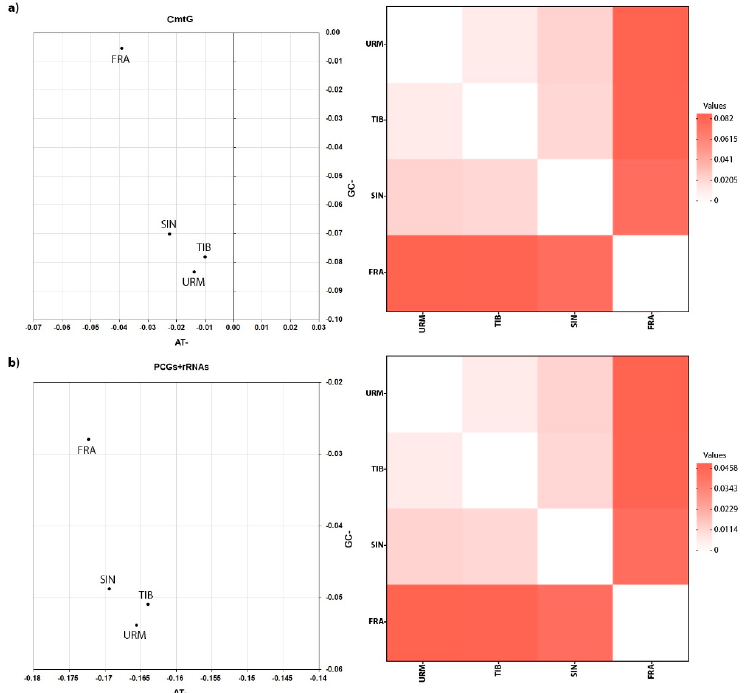
Figure 9. Distribution of species on scatter plots (left) and heat-map pairwise comparison (right) based on AT- and GC-skew values of CmtG ( a ) and PCGs+rRNAs ( b ) (URM: A. urmiana , TIB: A. tibetiana , SIN: A. sinica , FRA: A. franciscana ).